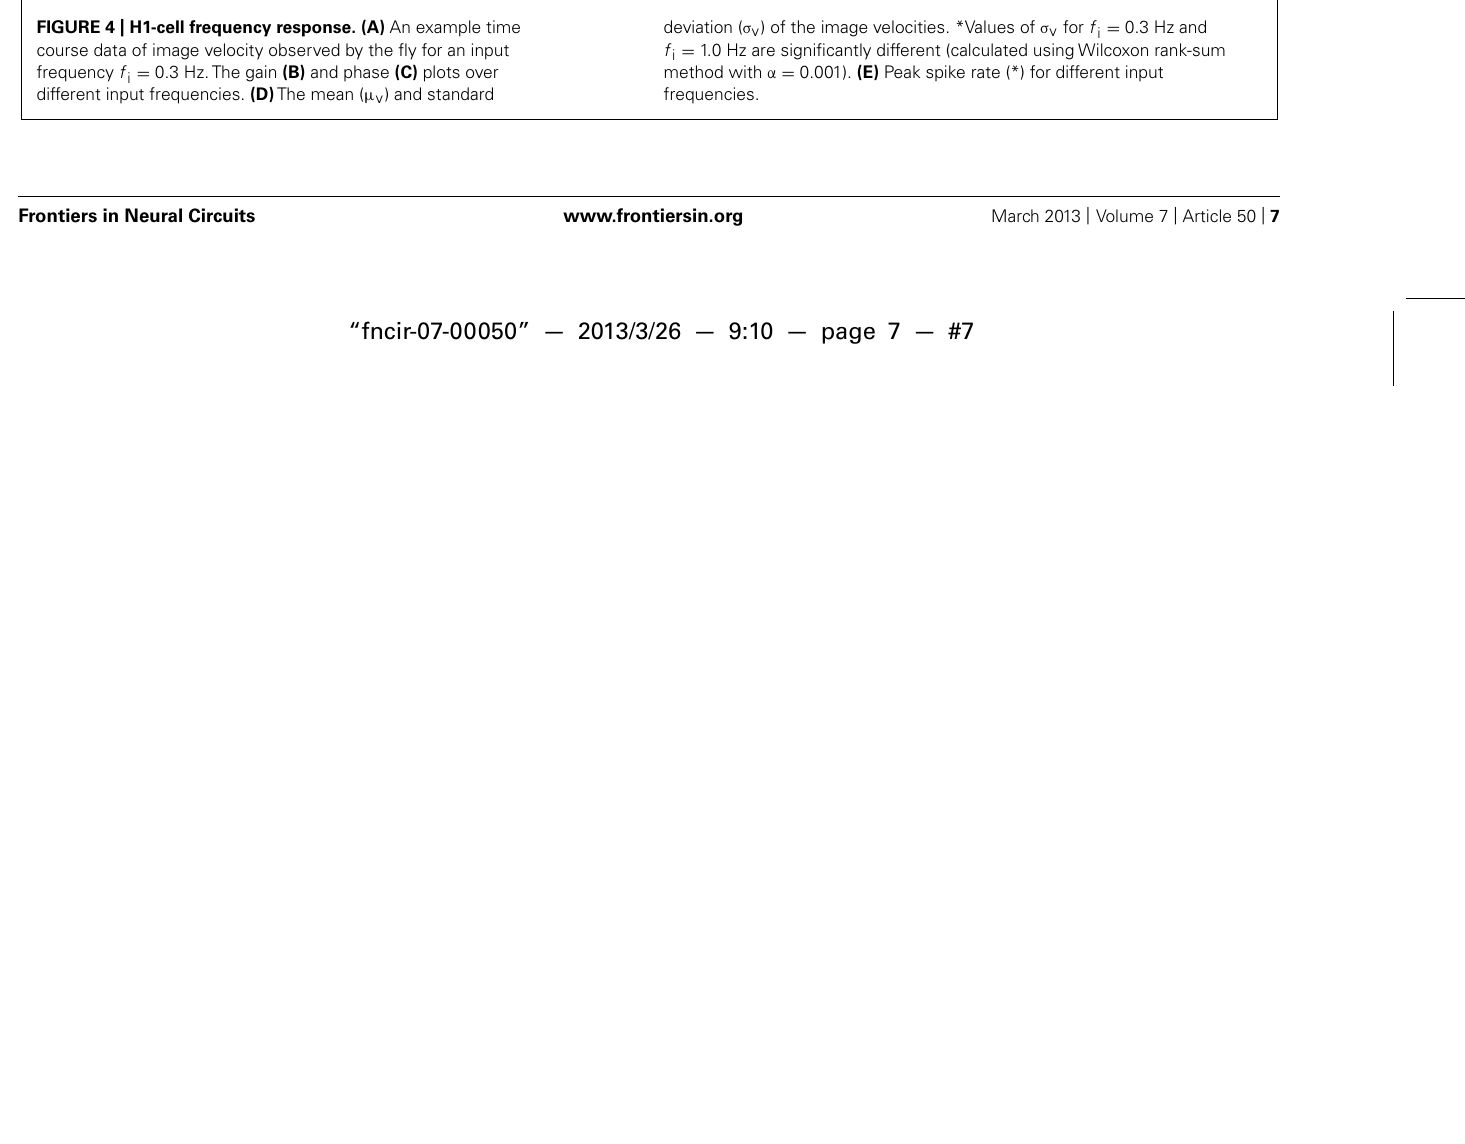
FIGURE 4 | H1-cell frequency response. (A) An example time course data of image velocity observed by the fly for an input frequency f i = 0.3 Hz.The gain (B) and phase (C) plots over different input frequencies. (D) The mean ( μ v ) and standard